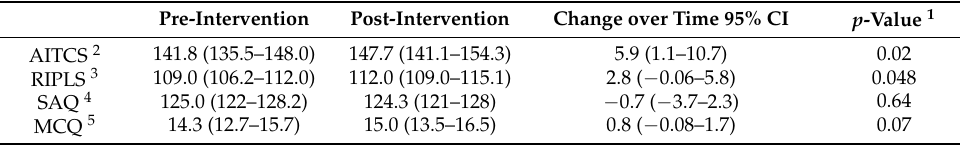
Table 4. All data are presented as estimated means and 95% confidence intervals